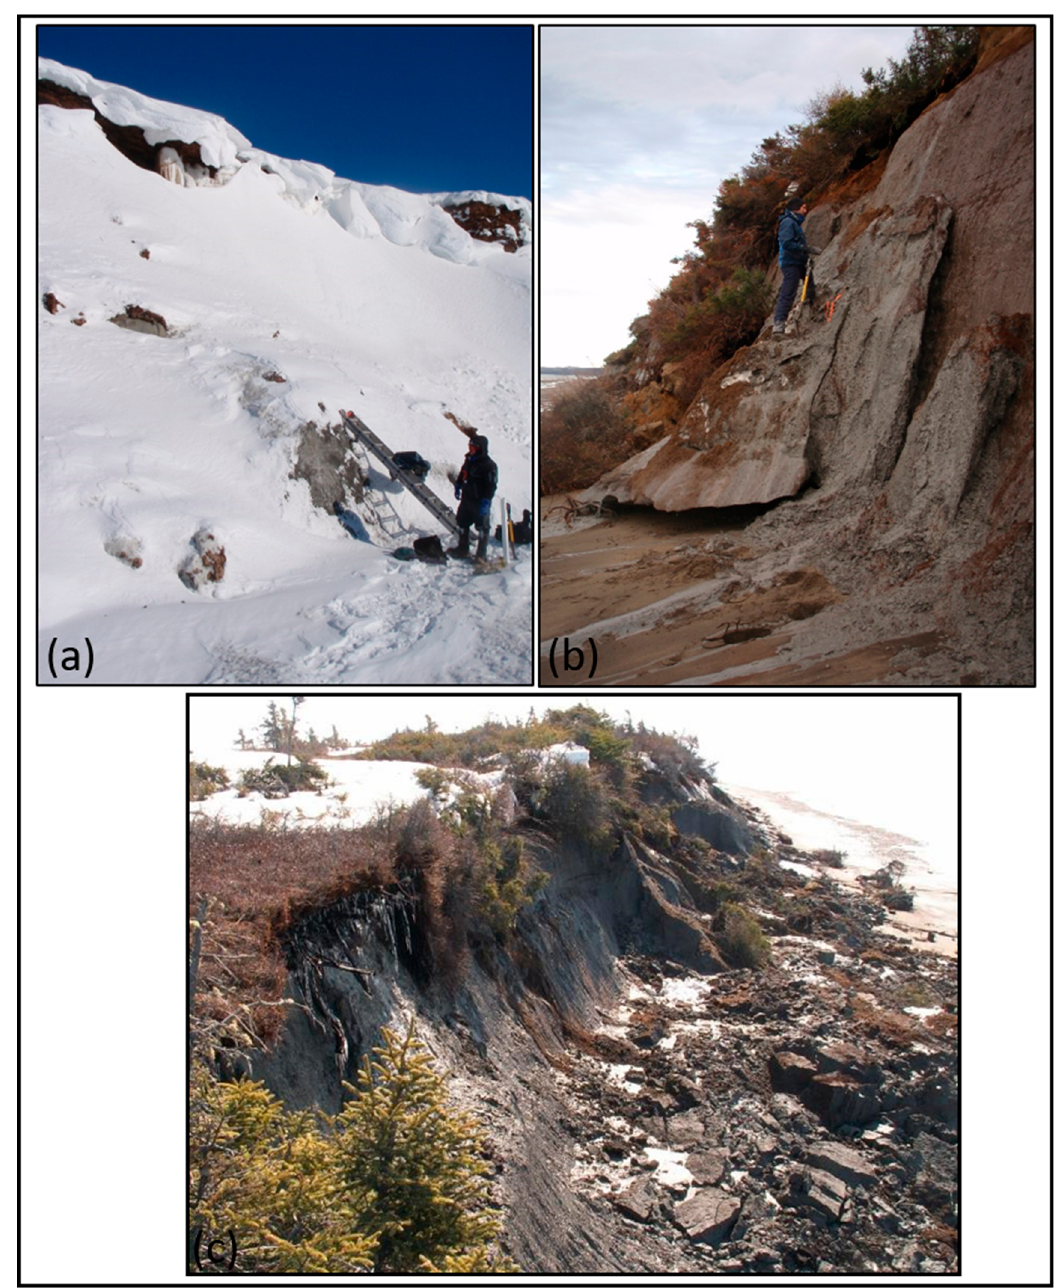
Figure 15. ( a ) Snow cover on the cliff protecting against daily thermal variations, 10 February 2009; ( b ) detachment of a slab at the contact between frozen and unfrozen sediments, 26 April 2009; ( c ) translational slide caused by vertical shear surface.